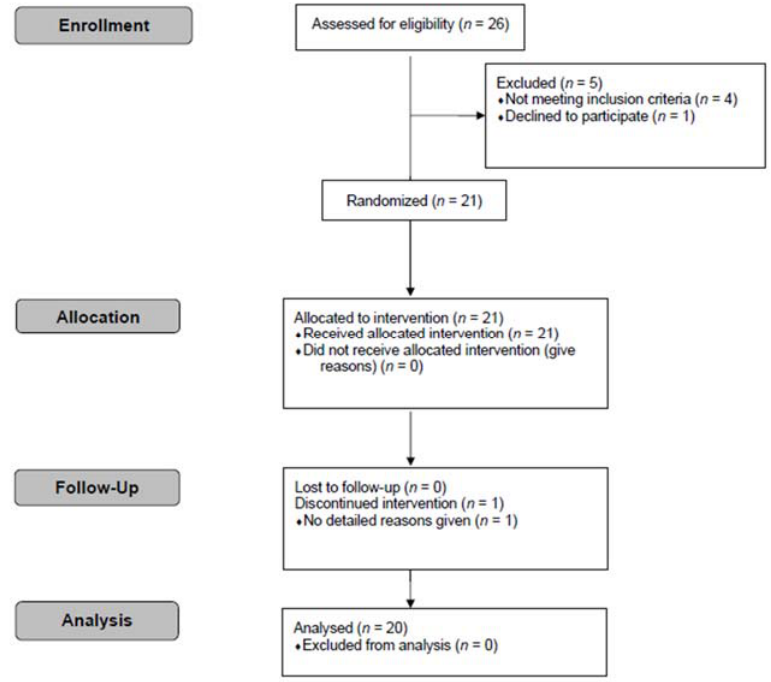
Figure 1. CONSORT flow diagram.